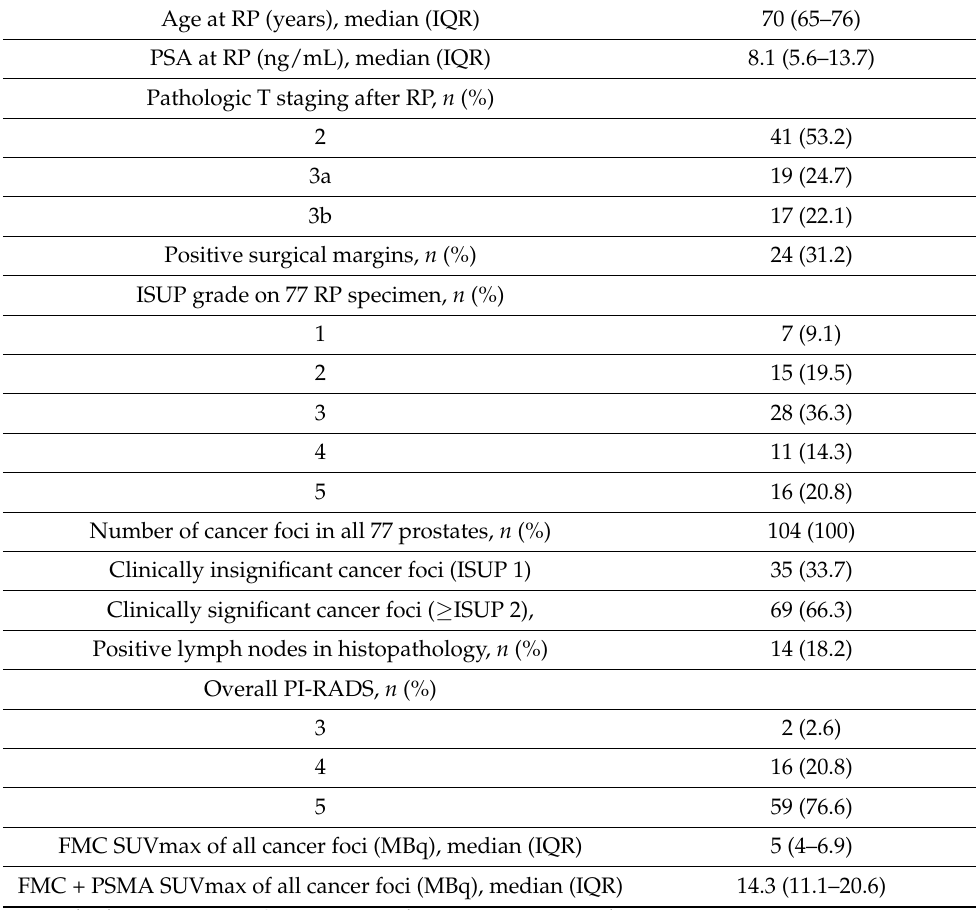
Table 1. Clinicopathologic features of 77 patients after 3T dual-tracer (FMC and PSMA) PET/mpMRI followed by robotic-assisted radical